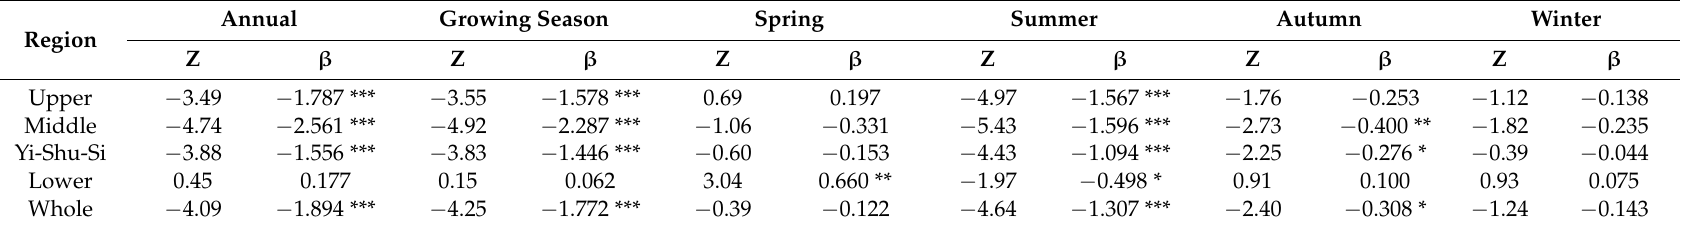
Table 2. Seasonal and annual trends of ET ref (mm · a − 2 ) during 1961–2014 in each region of the